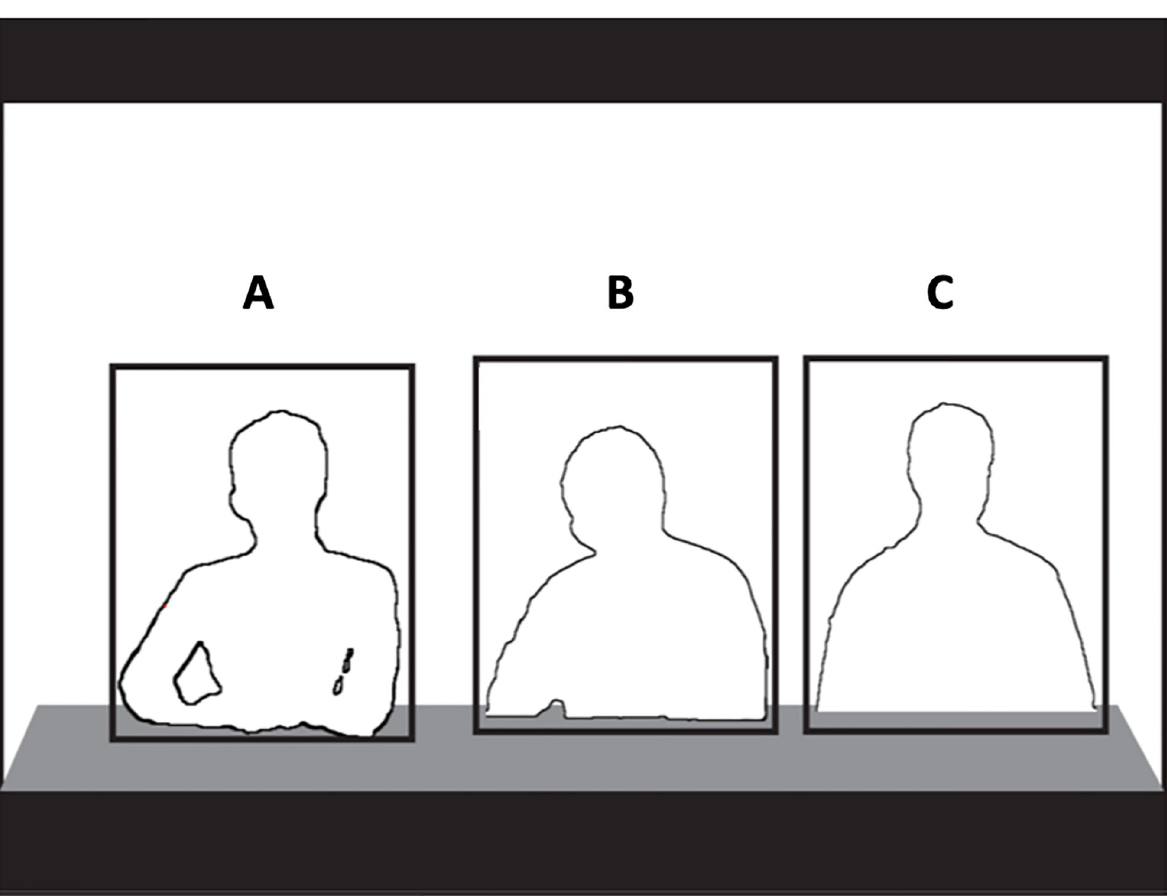
Fig 1. Participants’ view of targets in the video clips. Note . Example of the view of targets presented to participants (only the schematic is presented here to protect the privacy of the targets). After viewing the clips, and before completing the Dominance and Prestige Peer Rating Scales [88] for each target, participants were given a screenshot from the videos that identified the targets as A, B, or C. Adapted from “Gaze Allocation in a Dynamic Situation: Effects of Social Status and Speaking,” by Foulsham, et al., 2010. Cognition , 117 (3), p.